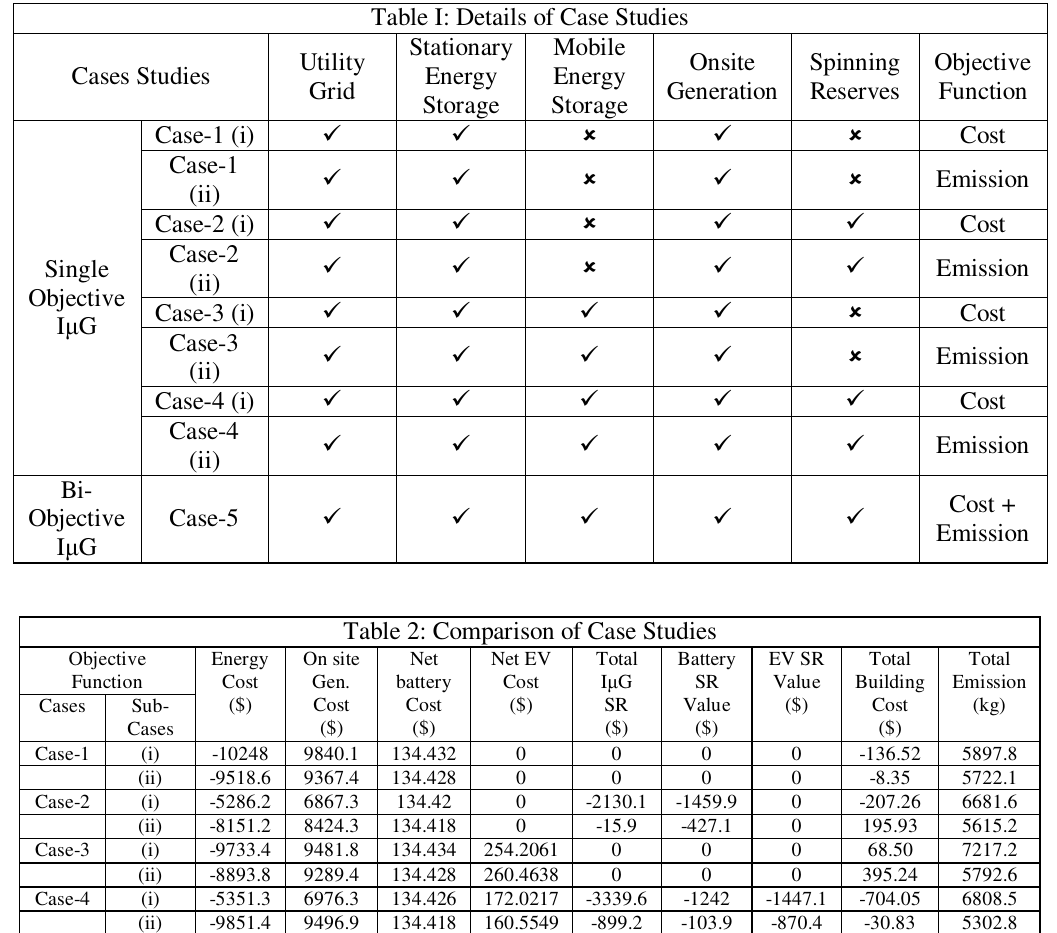
Table I: Details of Case Studies